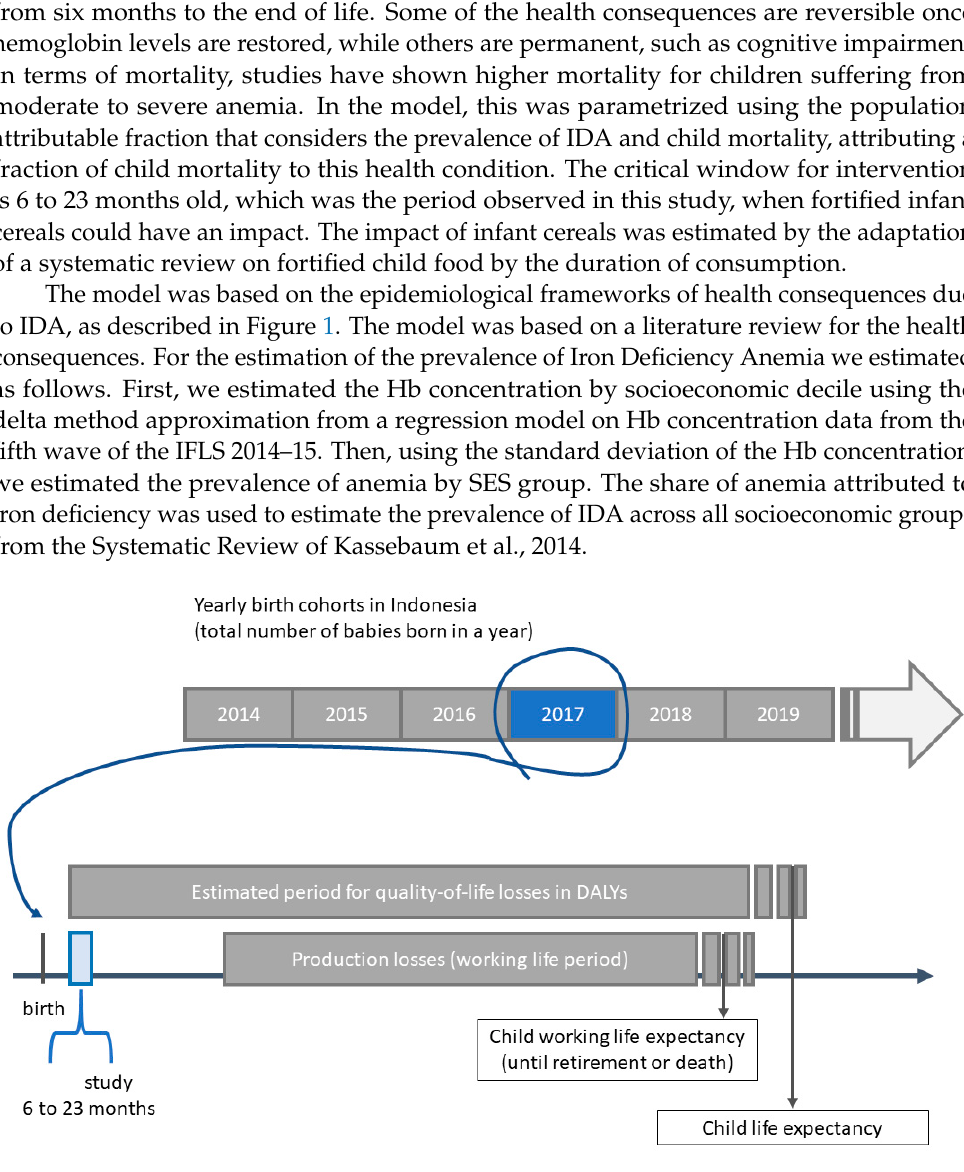
Table A1. Share of anemia due to iron deficiency and health consequences of IDA.